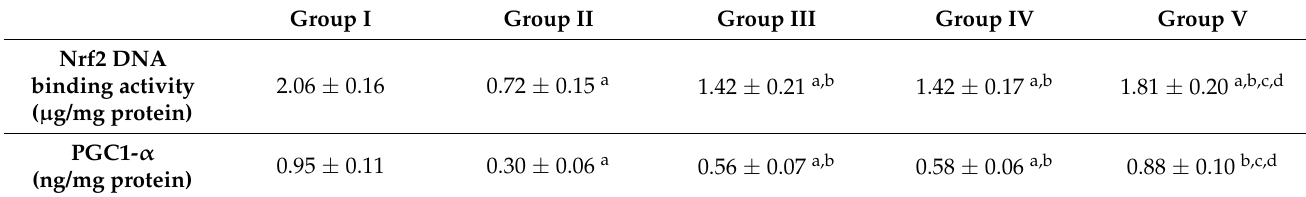
Table 3. Nrf2 DNA binding activity and PGC1- α levels.